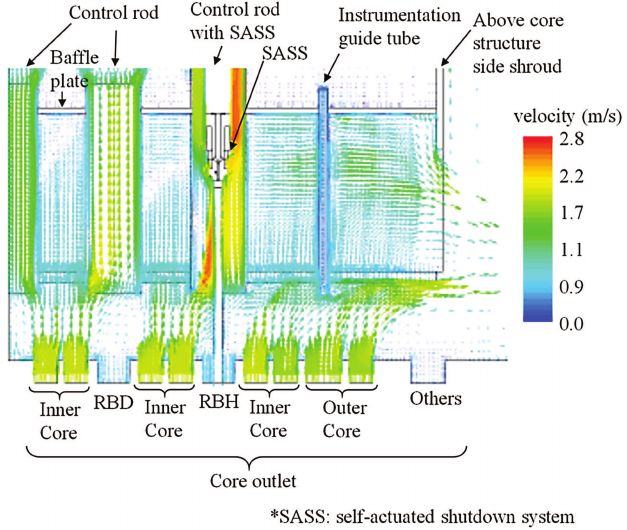
Fig. 6. Velocity distribution during normal operation.